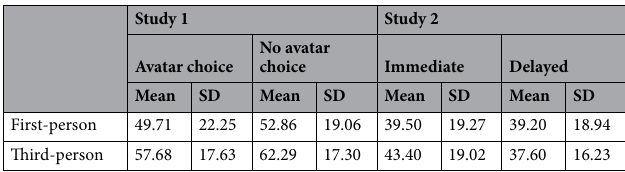
Table 2. Spatial memory accuracy (% correct).